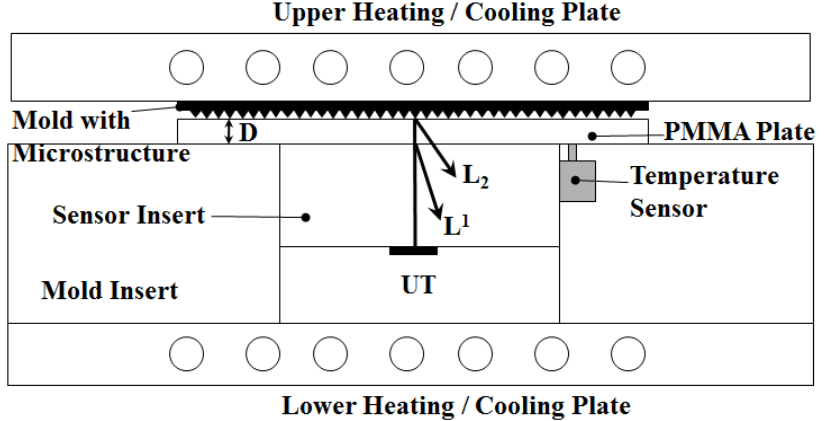
Figure 4. Schematic drawing of the cross-section of the experimental setup: The heating/cooling plates, the HTUT sensor insert with the mold and the mold insert, indicating the ultrasonic transmitting